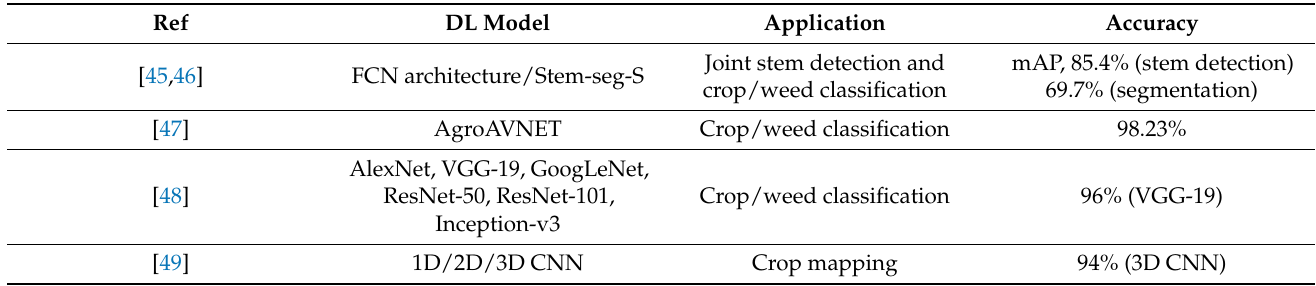
Figure 7. CropDeep deep-learning detection and classification models [44]. Table 2. Summary of different DL methods for crop